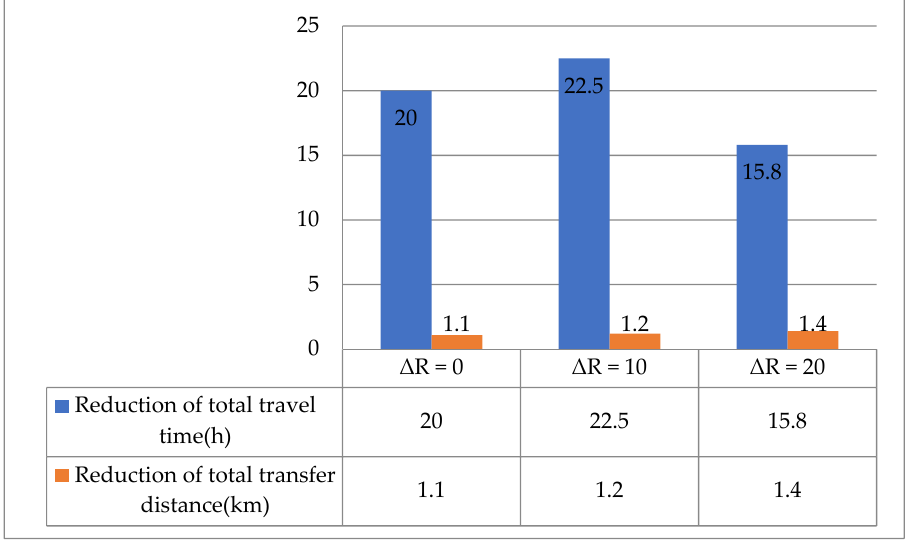
Figure 10. Comparative analysis of the conventional and proposed models for various station capacities.